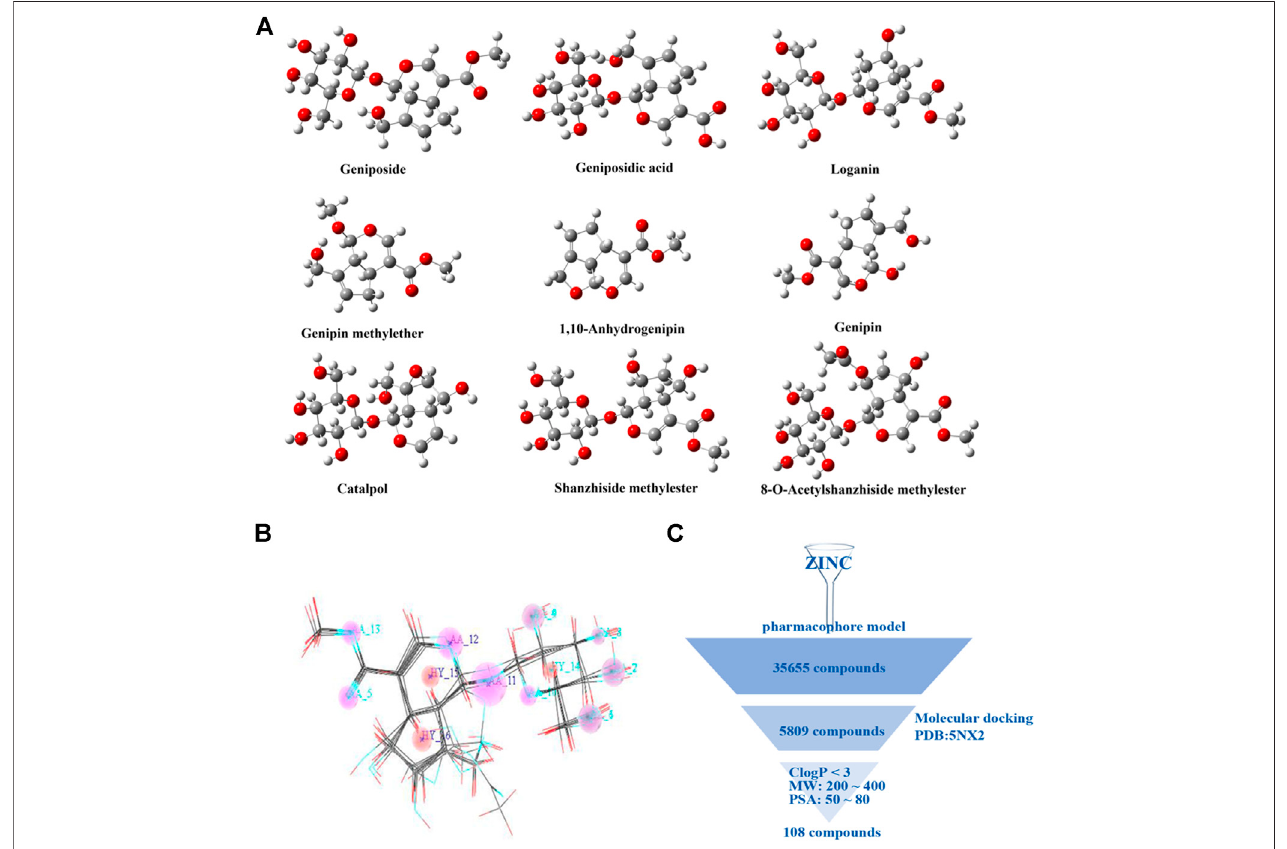
FIGURE 1 | Virtual screening of small molecule compounds. (A) Chemical structures of reported active molecules. (B) Pharmacophore model obtained from nine compounds. (C) Virtual screening work fl ow.